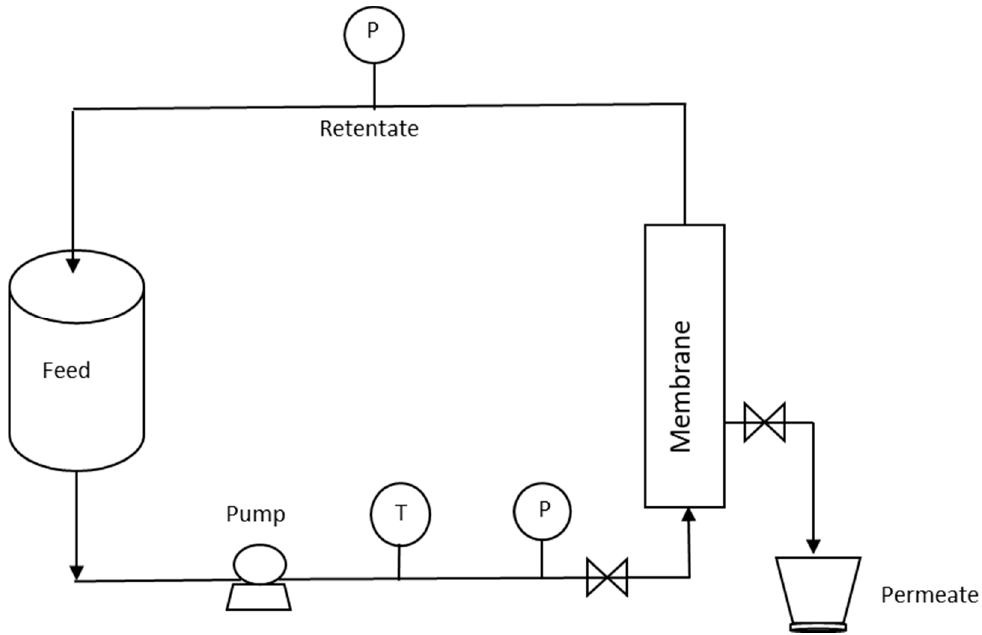
Figure 1. Simplified diagram showing the crossflow microfiltration process.